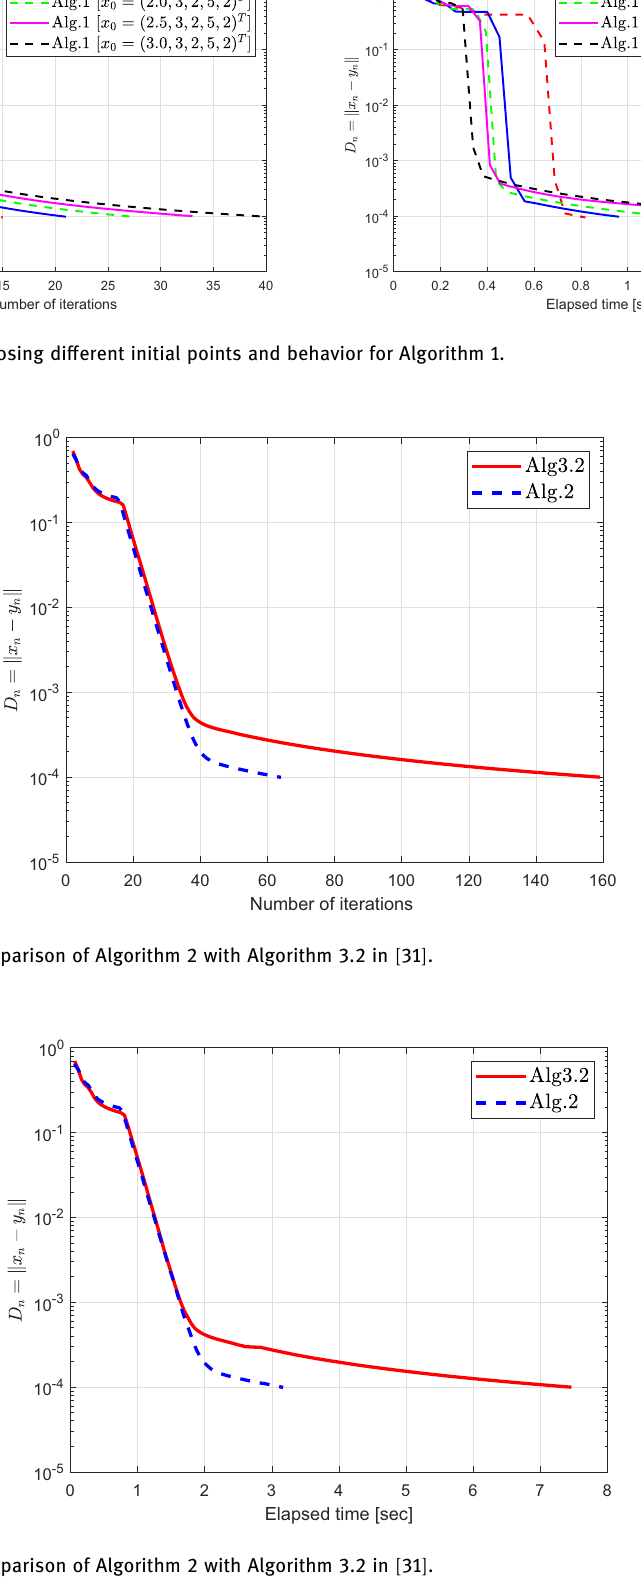
Figure 4: Example 6.1: Comparison of Algorithm 2 with Algorithm 3.2 in [ 31 ]